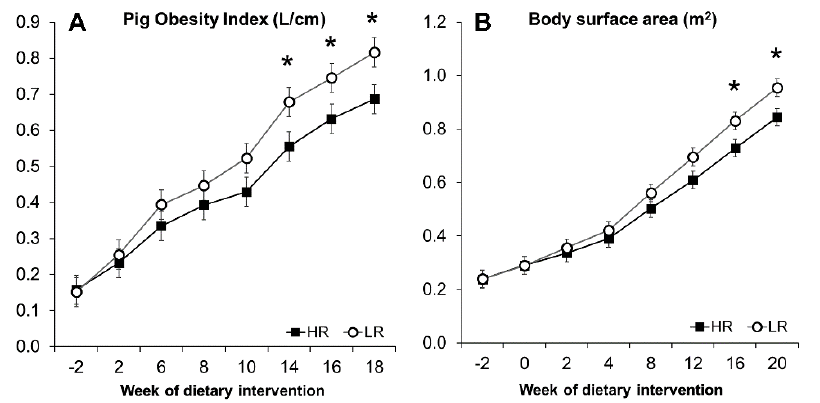
Figure 2. Pig obesity index ( A ) and body surface area ( B ) calculated from morphometric measurements. Results are expressed as LS means, error bars indicating SEM. Significant difference (* p < 0.05).